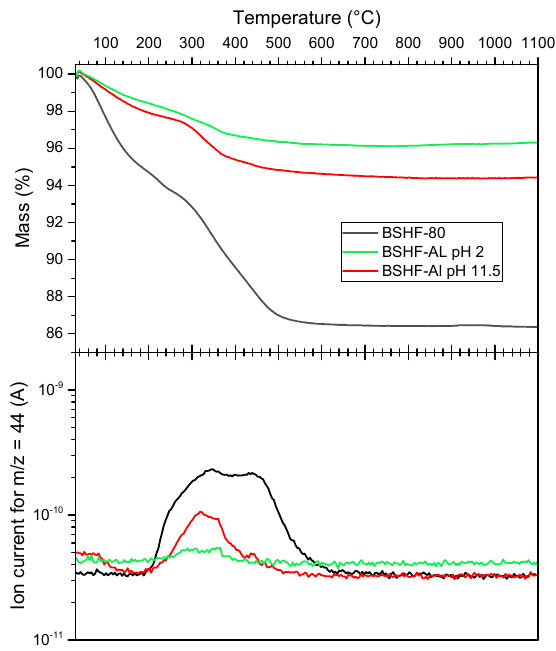
Figure 6. TGA of the BSHF-80 and AL-coated BSHF NPLs ( top ) with the corresponding MS spectra ( bottom ) for m/z = 44 (i.e., CO 2 ).